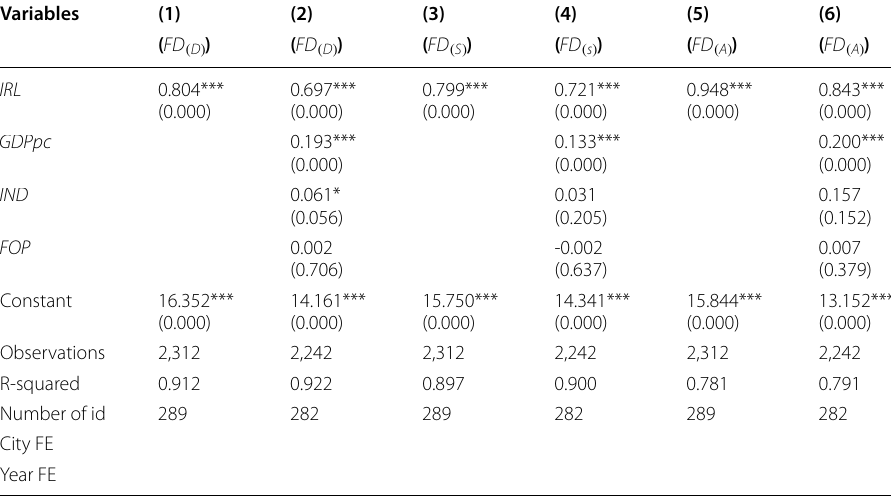
P values are shown in parentheses ***, **, and *, significance at 1%, 5%, and 10% levels,